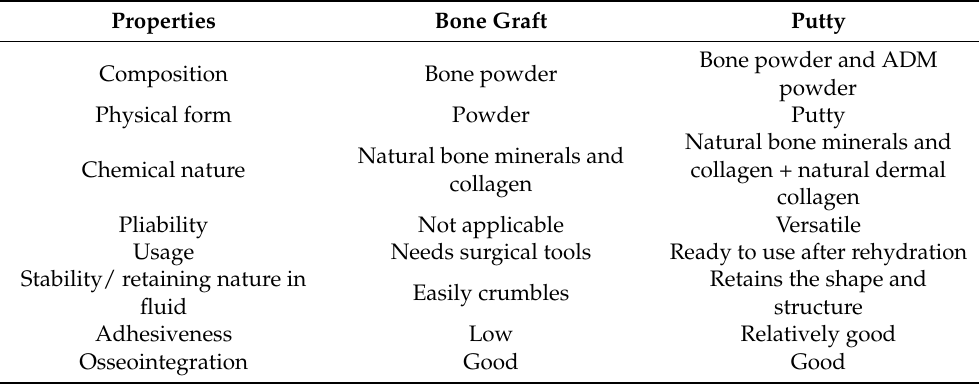
Table 2. Comparison of bone graft and